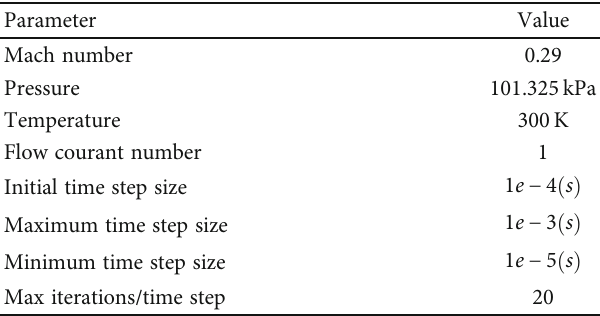
Table 1: Air and calculation parameter